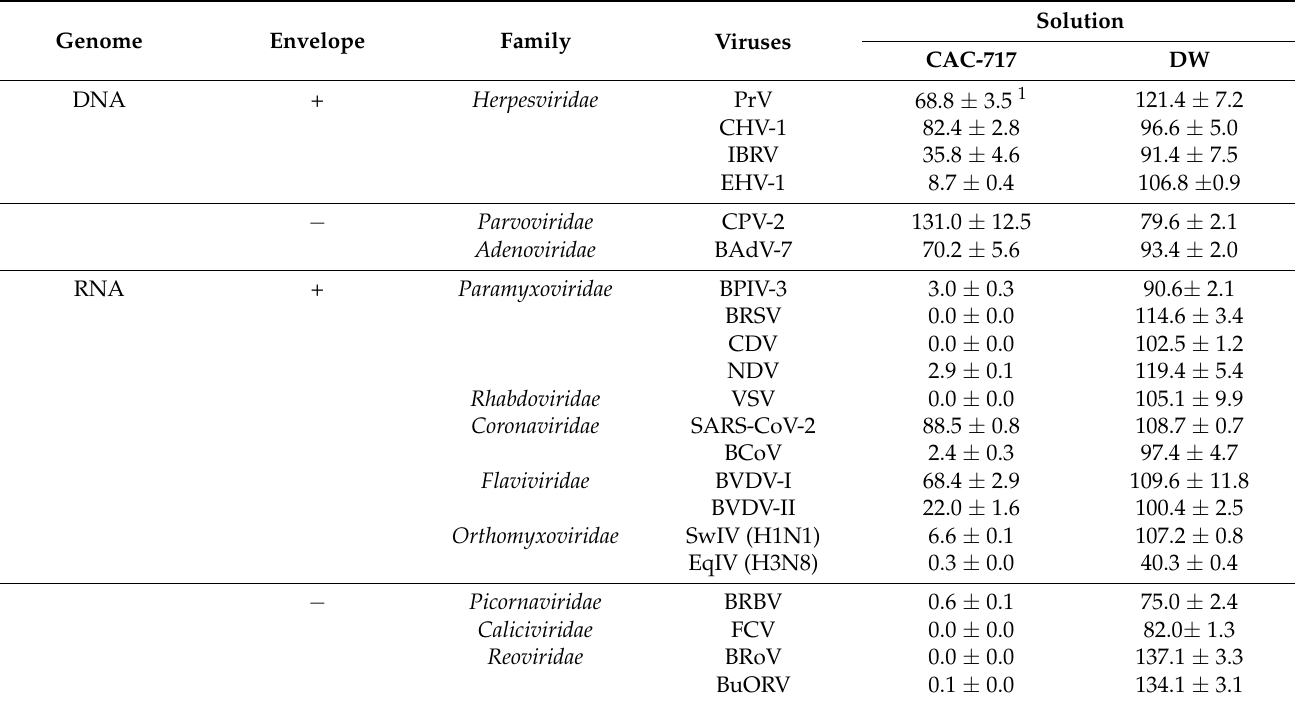
Table 5. Genome quantification of DNA and RNA viruses treated with CAC-717 for 60 min. Genome